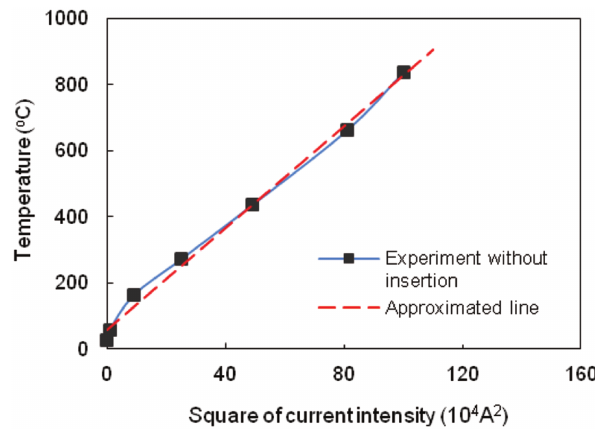
Figure 5: Relationship between the billet heating temperature and the square of current intensity.